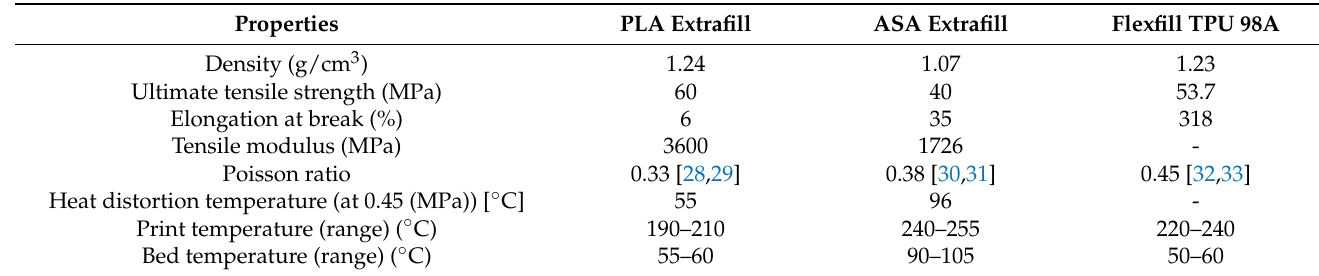
Table 1. Main properties of the chosen materials